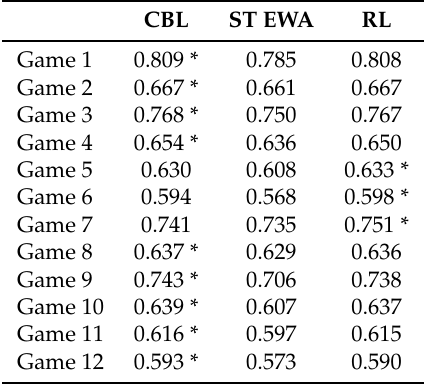
Table A3. In-sample Fit by Game: Mean Quadratic Score * denotes the best-fitting model based on the mean quadratic score. CBL has five estimated parameters, RL has four estimated parameters, and